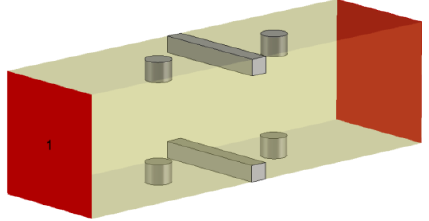
FIGURE 1. General view of a waveguide polarizer with diaphragm and pins.